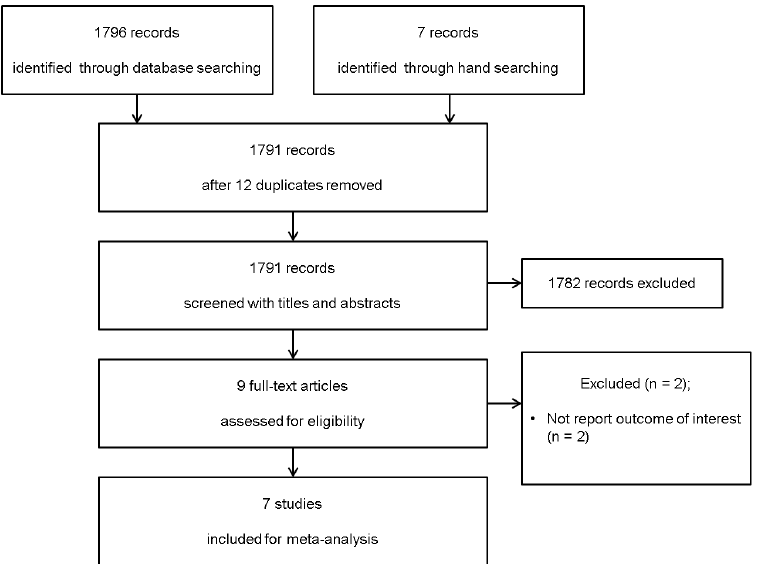
Figure 1. Flow diagram showing the number of abstracts and articles identified and evaluated during the review.